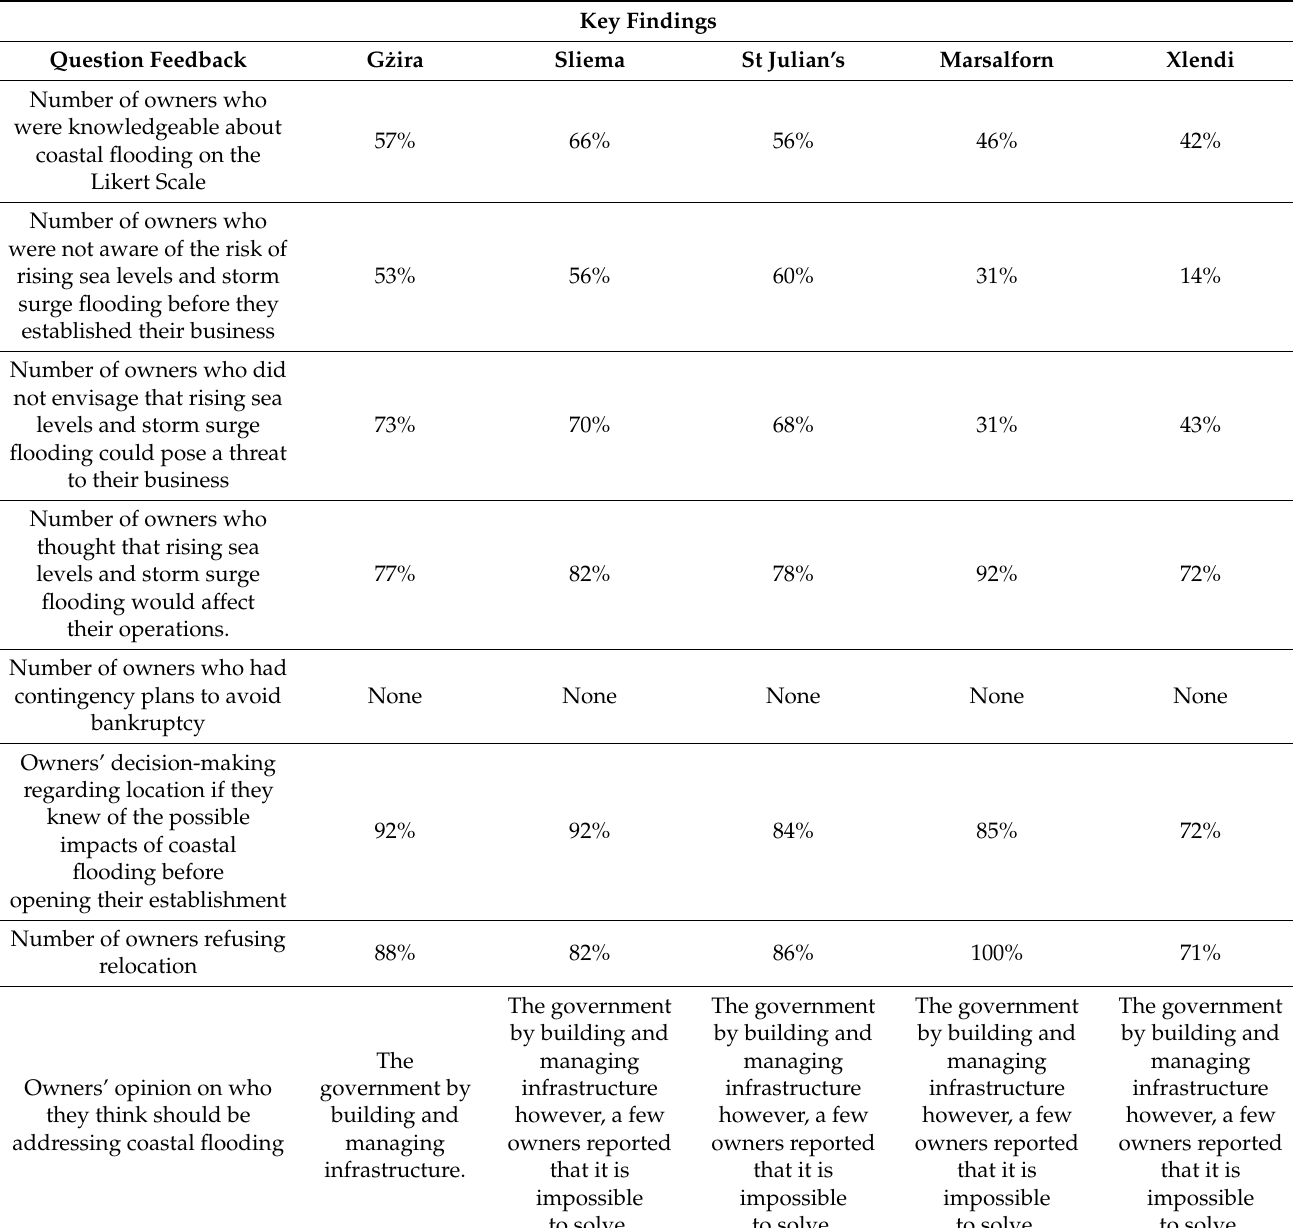
Table 1. Feedback from interviews held with business communities of five selected